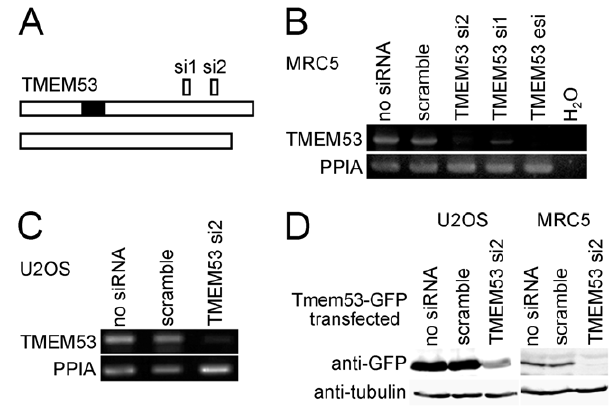
Figure 6. Knockdown of NET4/TMEM53 in U2OS and MRC5 cells. (A) Splice variants and position of knockdown oligos. (B) NET4/ TMEM53 transcript levels were effectively knocked down in MRC5 cells using both siRNA oligos and an esiRNA. Peptidylprolyl isomerase A (PPIA) was used as a control for normalization. (C) NET4/TMEM53 transcript levels were also knocked down in the U2OS cell line using the siRNA oligo TMEM53 si2. The scramble siRNA oligo had no effect. PPIA was used as a control for normalization. (D) Western blot demonstrating the knockdown of NET4/Tmem53. Because antibodies to NET4/Tmem53 recognized multiple bands on Western blot at the expected molecular weight, knockdown of the protein was tested using a NET4/Tmem53- GFP fusion and GFP antibodies. The siRNAs were transfected 24 h after transfection of NET4/Tmem53-GFP in order to enable protein to be generated from the plasmid prior to the beginning of knockdown.